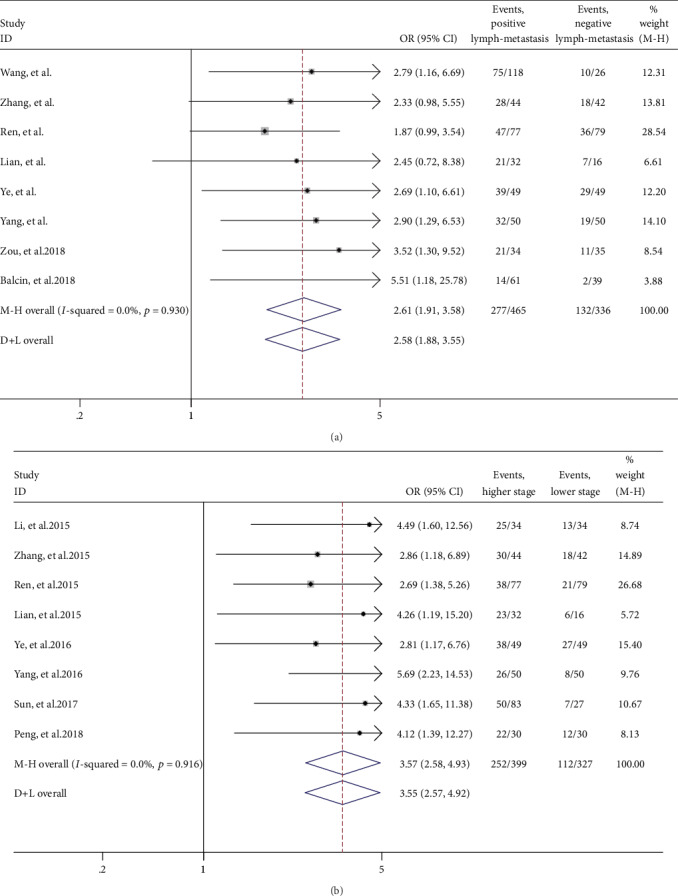
Forest plot for the association between HOTTIP expression levels with LNM notes (a) and clinical stage (b).